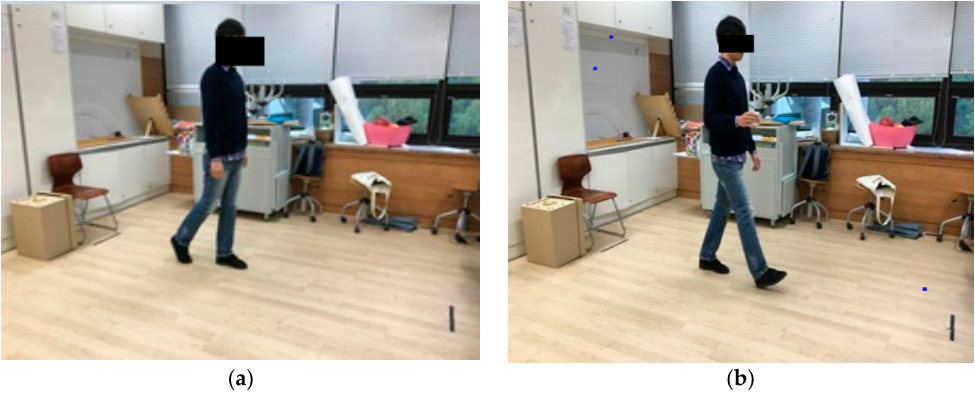
Figure 1. Examples of Dual tasks using Timed up and Go test (TUG). ( a ) TUG-motor dual task, the subject walks with a glass of water in his hand; ( b ) TUG-Cognitive motor dual task, the subject walks while counting backwards.